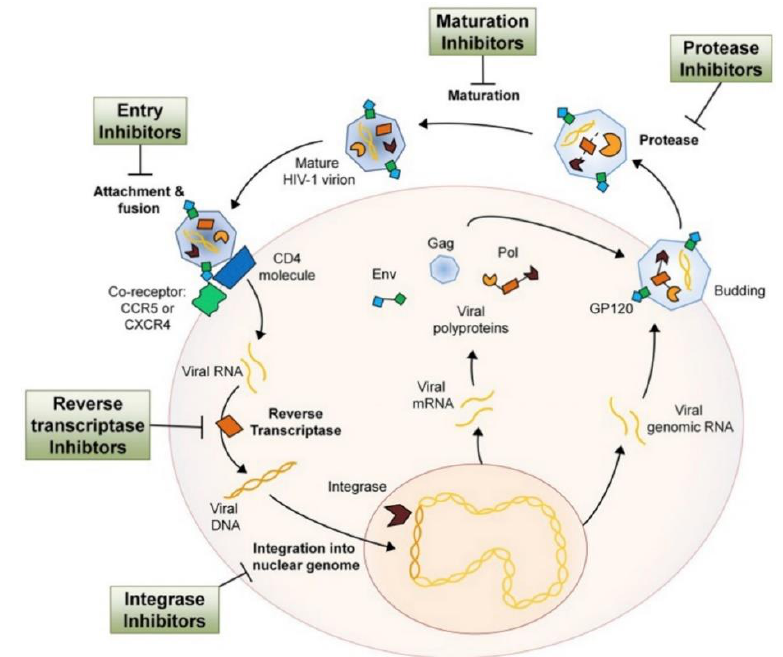
Figure 3. Schematic description of the mechanism of currently available ARV drugs against HIV. Reprinted with permission from [96].